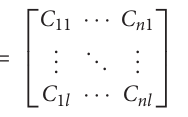
FIGURE 4 | Mean square error on Leukemia